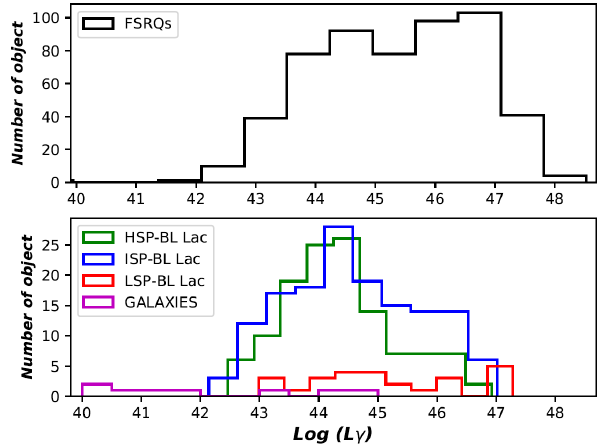
Figure 1. Distributions of γ -ray luminosity for FSRQs and BL Lac